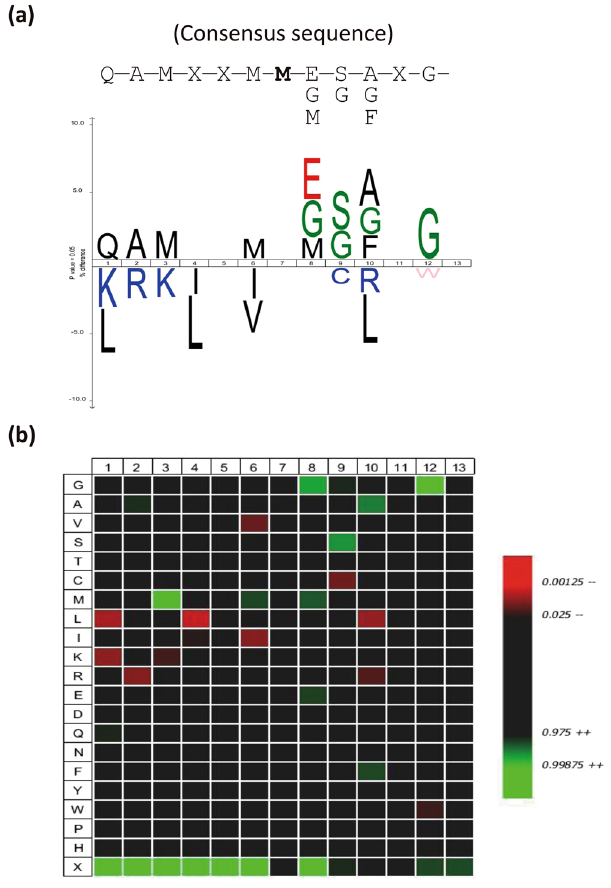
Figure 6. The consensus sequence of the oxidized Met-peptides, as analyzed using the iceLogo software. The frequencies of each amino acid at positions surrounding the oxidized Met residues of the 431 oxidized Met-peptides from three PDT conditions were analyzed with the iceLogo software, using a reference database containing all of the non-oxidized Met-peptides identified in our experiments. ( a ) The high- and low-frequency amino acid residues are shown at upper and lower part of the iceLogo, respectively. The oxidized Met residue is set at position 7. ( b ) A heat map generated from the same analysis. In both panels, only significantly overrepresented amino acid residues ( P < 0.05) are